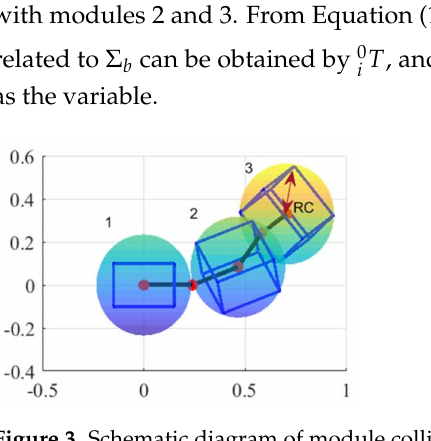
Figure 3. Schematic diagram of module collision and